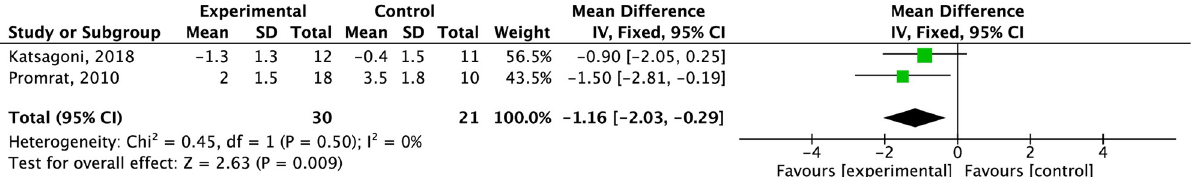
PLOS ONE | https://doi.org/10.1371/journal.pone.0263931 February 17,